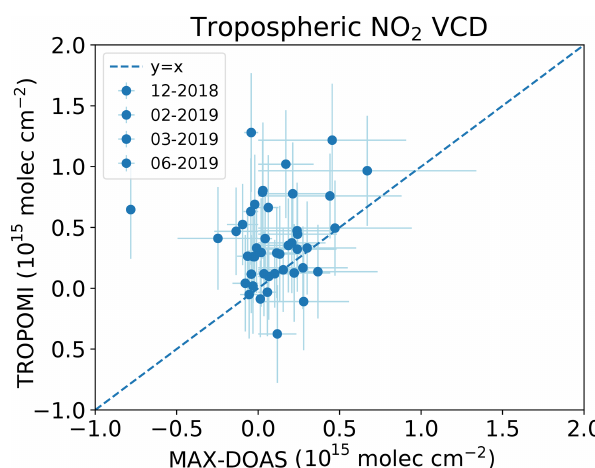
Figure 10. Time series of TROPOMI (blue) and collocated MAX- DOAS (red) tropospheric NO 2 vertical column densities for the cruise in February 2019. The missing TROPOMI data are due to clouds. The error bar shows the precision of the TROPOMI tropo- spheric NO 2 VCD.